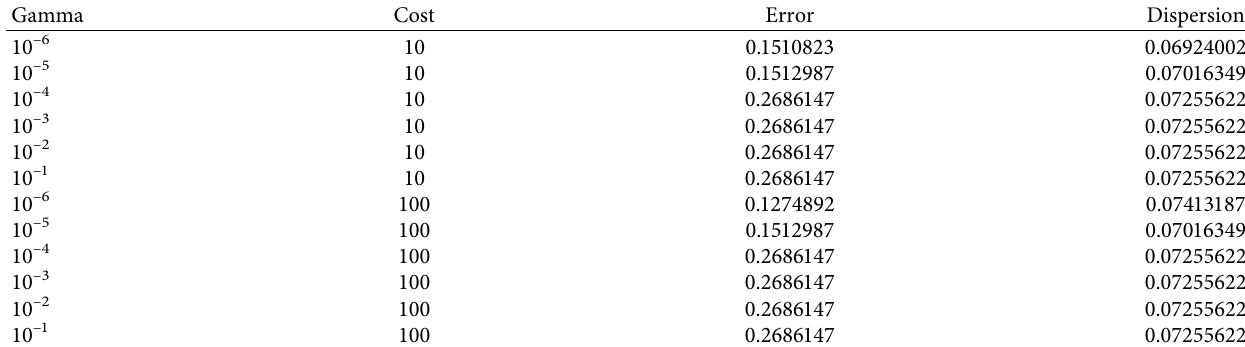
Table 2: Optimal values under SVM